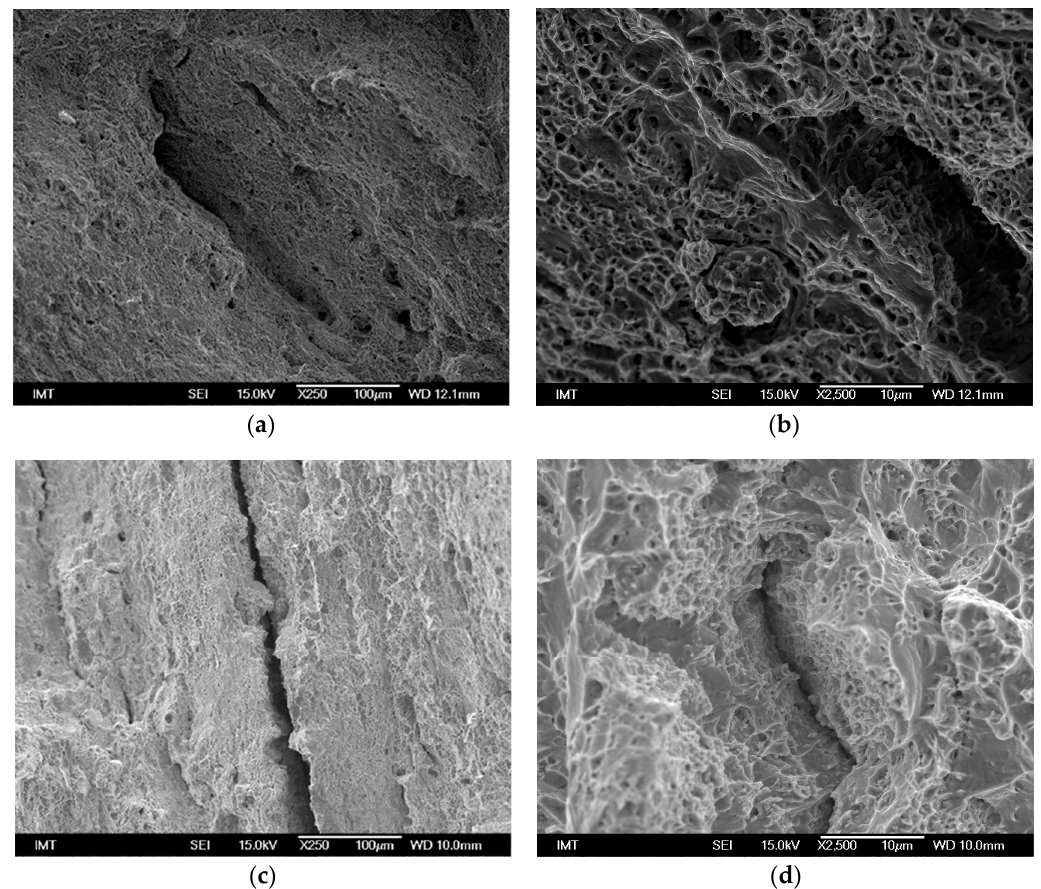
Figure 18. The Fracture surfaces of the samples hot rolled at 1050 °C with the deformation level of 23.5% (unaged) ( a,b ) and aged at 750 °C for 5 h ( c,d ).